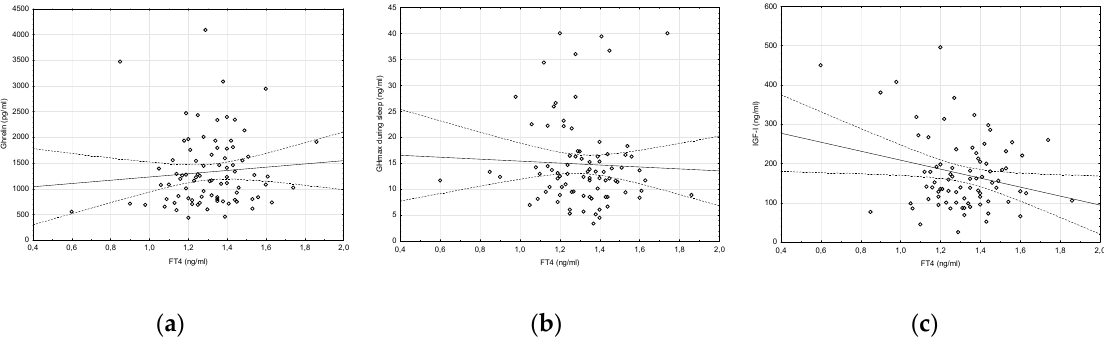
Figure 1. Correlation between: ( a ) TSH (thyroid stimulating hormone) and ghrelin concentrations (r = +0.44, p < 0.05); ( b ) TSH concentration and GHmax concentration during sleep (r = − 0.25, p < 0.05); ( c ) TSH and IGF ‐ I concentrations (r = − 0.3, p < 0.05).